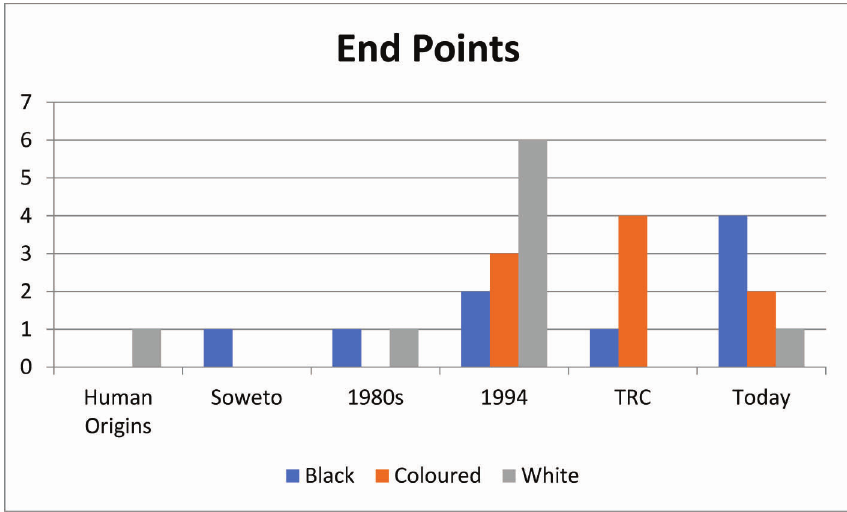
Figure 2: EndpointsselectedbystudentsfortheirnarrativesofSouthAfrica,byrace Thereisasimilardifferenceintheendpointchosenforthestudentnarratives.Two-thirdsof